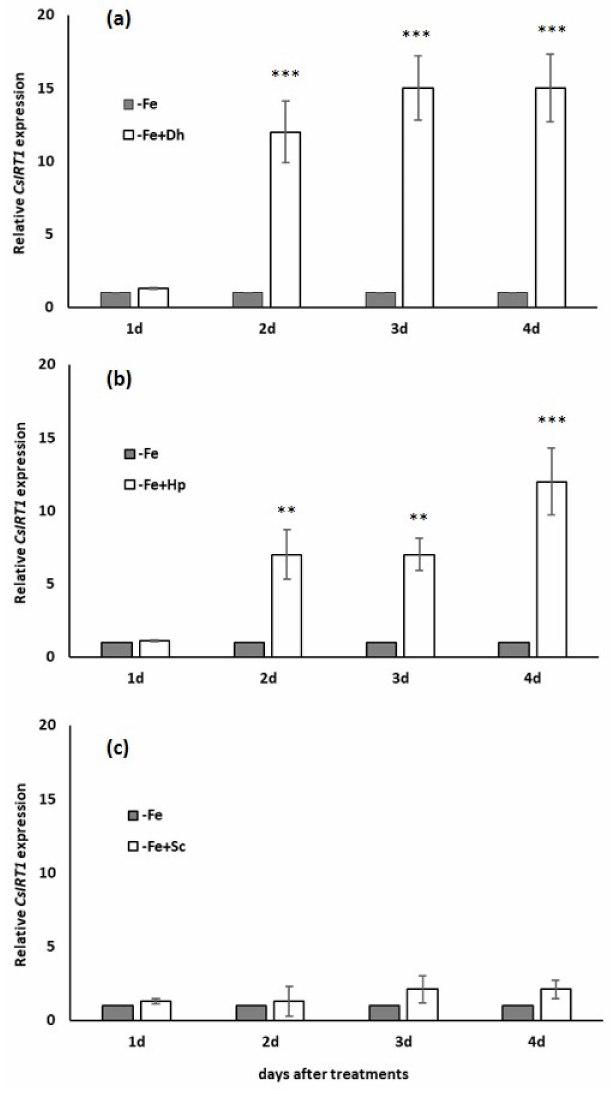
Figure 3. Time course of CsIRT1 expression in cucumber plants over the 4 days of treatments. Treat- ments: (control) without Fe ( − Fe) and (inoculated) inoculation with different yeasts, Debaryomyces hansenii ( − Fe+Dh) ( a ), Hansenula polymorpha ( − Fe+Hp) ( b ), or Saccharomyces cerevisiae ( − Fe+Sc) ( c ). The inoculation was carried out the same day Fe-deficiency treatment was applied. Data CsIRT1 expression represent the mean ± SE of three independent biological replicates and two technical replicates. Within each day, bars with ** or *** indicate significant differences ( p < 0.01 or p < 0.001) in relation to the –Fe treatment according to the Dunnett’s